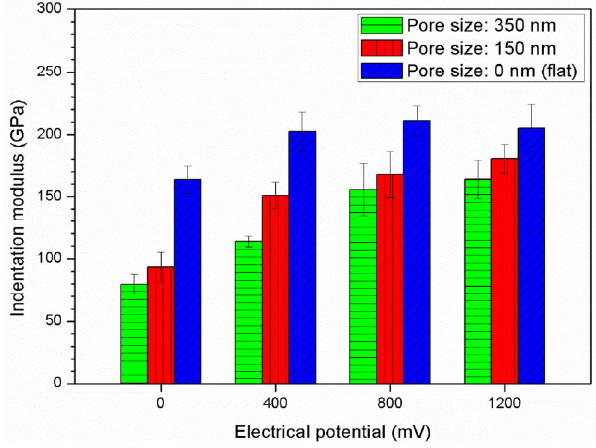
Fig. 3 Representative load and indentation depth curves for metallic porous nanostructures with various pore sizes.